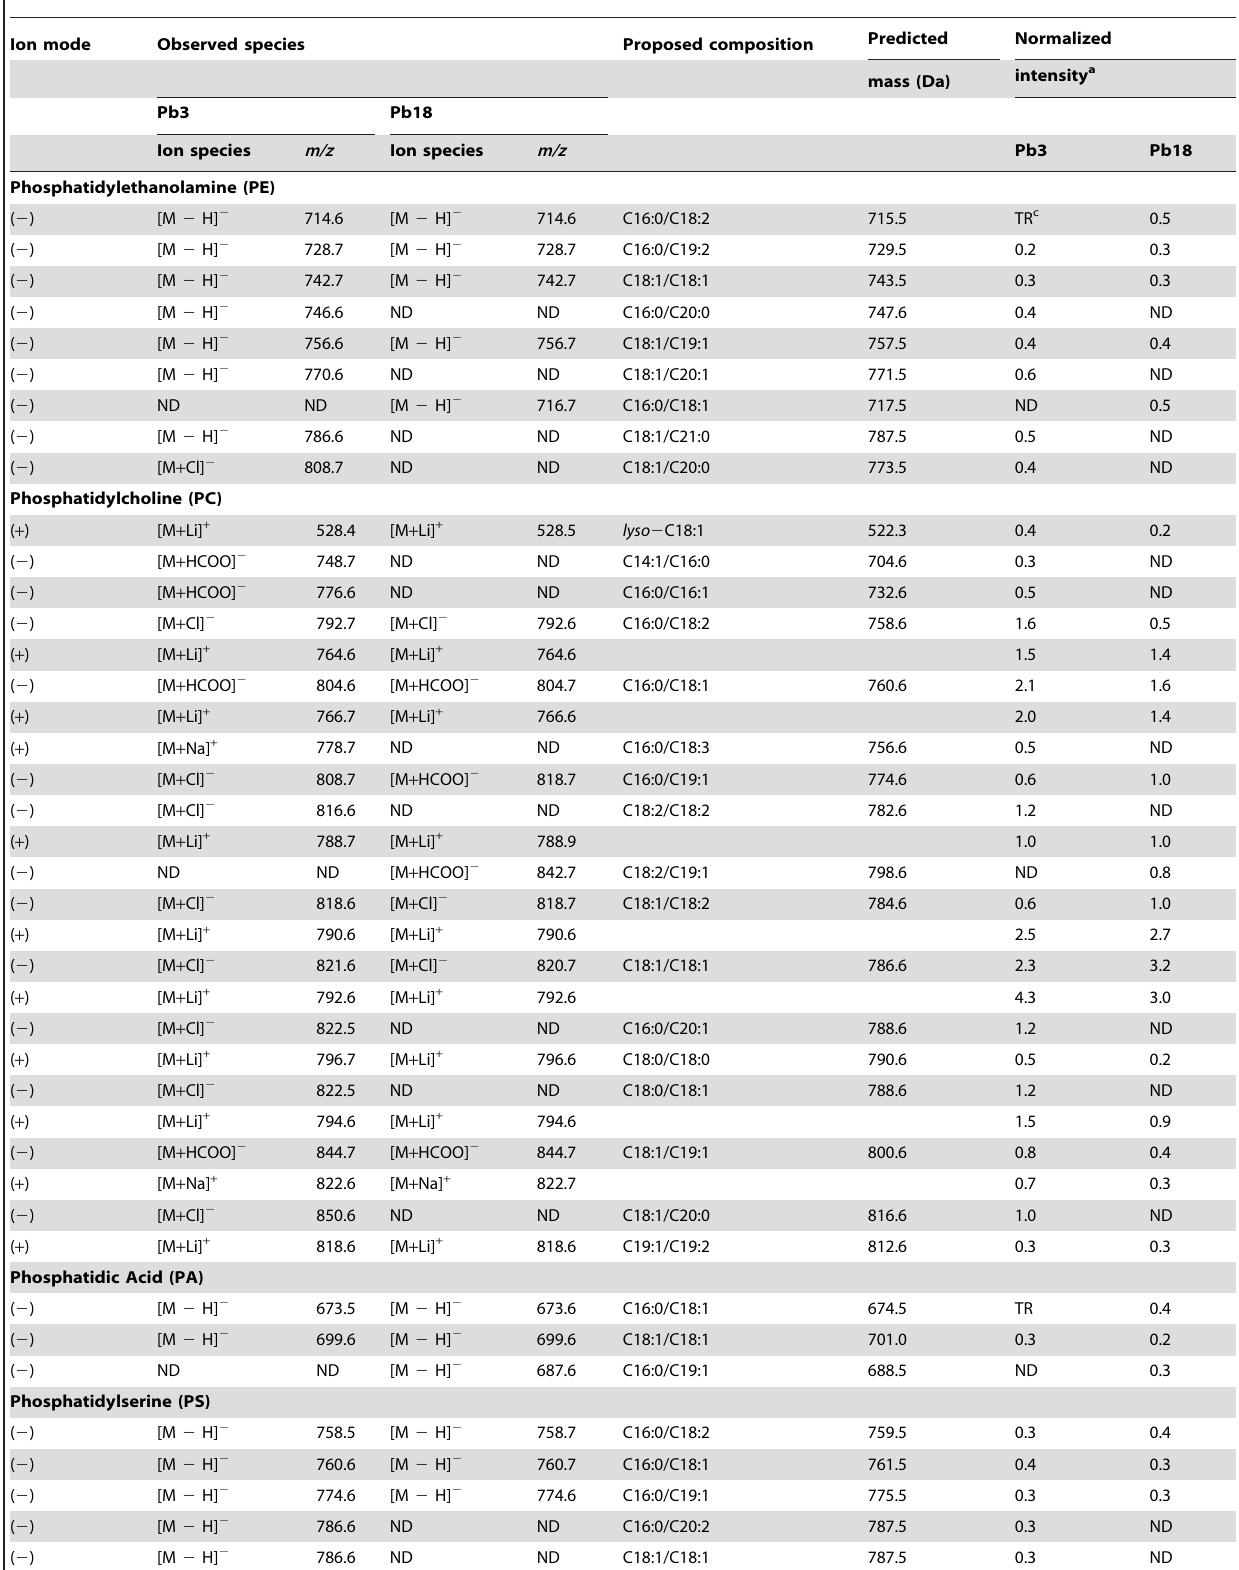
Table 1. Composition and relative abundance of major phospholipids from Pb3 and Pb18 cell wall identified by ESI-MS total-ion